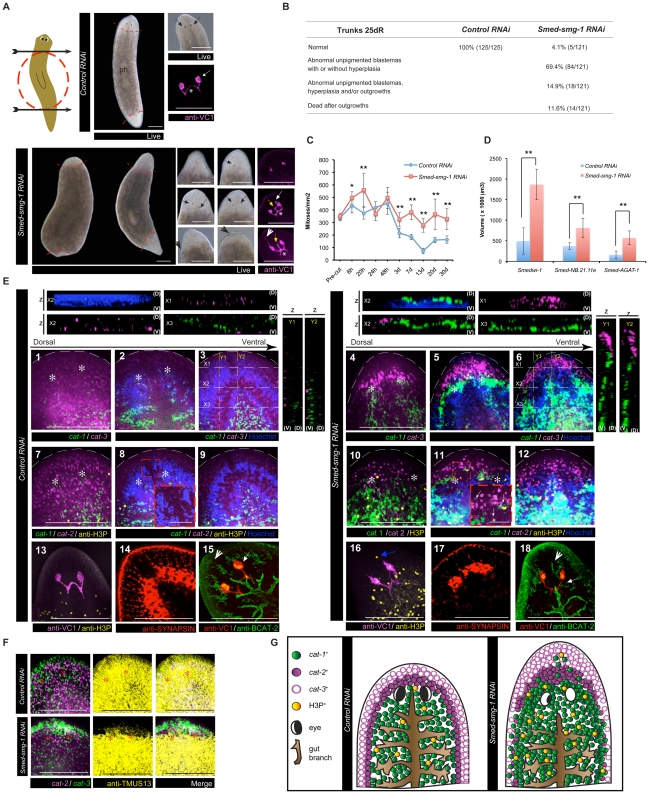

Smed-smg-1 is required to restrict blastema growth during regeneration.A. The cartoon shows the levels of transverse amputation performed in the experiment (arrows) and highlights the trunk piece (dotted red circle), which was kept to follow anterior and posterior regeneration in all the experiments. Panels show 20–25 dR trunks. Dotted red lines define the blastemas. ph indicates the pharynx. Smed-smg-1(RNAi) animals show varying size of abnormal unpigmented blastemas with several degrees of eye differentiation displayed by the eye pigmentary cup in the live images (black arrows) and the VC1 staining. Asterisk shows a thickened optic chiasm, the white arrow shows an extra eye as an accumulation of unilateral photoreceptor clusters, always more anteriorly positioned than the original eyes, the yellow arrow shows abnormal axonal projections, and the white arrowhead shows an aberrant antero-dorsal photoreceptor projection. The black arrowhead shows epidermal hyperplasia. B. Table summarising the phenotypes observed in trunks at 25 dR; hyperplasia refers to epidermal hyperplasia observed in live animals. C, D. Mitotic numbers during different time points of regeneration and volume of the different neoblast compartments at 20 dR, respectively. Error bars are s.d from the mean and asterisks indicate P<0.05 (one asterisk) or P<0.01 (two asterisks) using two-tailed Student's test with equal sample variance. C. n≥5 planarians per time point in at least two independent experiments; D. n≥4. E. Panels show maximum confocal projections for the dorsal-most sections (1, 7, 4 and 10), the medial sections (2, 8, 5 and 11) and the ventral-most sections (3, 9, 6 and 12) of 20 d anterior regenerating trunks. Asterisks indicate the position of the eyes. Panels show the distribution of neoblasts (cat-1), neoblast early progeny (cat-2) and neoblast late progeny (cat-3) markers in controls versus Smed-smg-1(RNAi) animals. The inset in 8 and 11 show the presence of cat-1 and H3P+ cells in the cat-2 and cat-3 compartment in front of the eyes in Smed-smg-1(RNAi) animals. Strips represent confocal XZ or YZ projections (D is dorsal and V is ventral) demonstrating a greater volume of neoblasts and progeny, an accumulation of cat-1 cells dorsal to the brain ganglia (X2 and Y1) and a higher accumulation of cat-3 at the anterior tip of the planarian (X1, Y1, Y2) in Smed-smg-1(RNAi) compared to controls. n≥4. Lower panels show H3P+ cells (panels 13 and 16, blue arrow) in front of the eyes (maximum confocal projection; n = 4/8), a very undeveloped brain labelled by anti-SYNAPSIN staining (panels 14 and 17; dorsal maximum confocal projection), an anterior gut branch (seen in BCAT-2 staining; maximum projection) aberrantly located with respect to the position of the eyes (n = 4/6, the white arrow indicates the most anterior level reached by the anterior gut branch) and the epithelium of protonephridial tubules stained by anti-BCAT-2 not reaching the tip of the planarian (panels 15 and 18; white arrow head; n = 6/6) in Smed-smg-1(RNAi) animals. F. Panels show maximum confocal projections of 20 d anterior regenerating trunks. The tip of the blastema shows minimal differentiation of muscle cells (stained with anti-TMUS13) in Smed-smg-1(RNAi) planarians. n = 3/3. G. Cartoons summarising the phenotype observed during anterior regeneration of 25 dR trunks. Scale bars represent 300 µm. Scale bars in (E) high magnification images represent 50 µm.